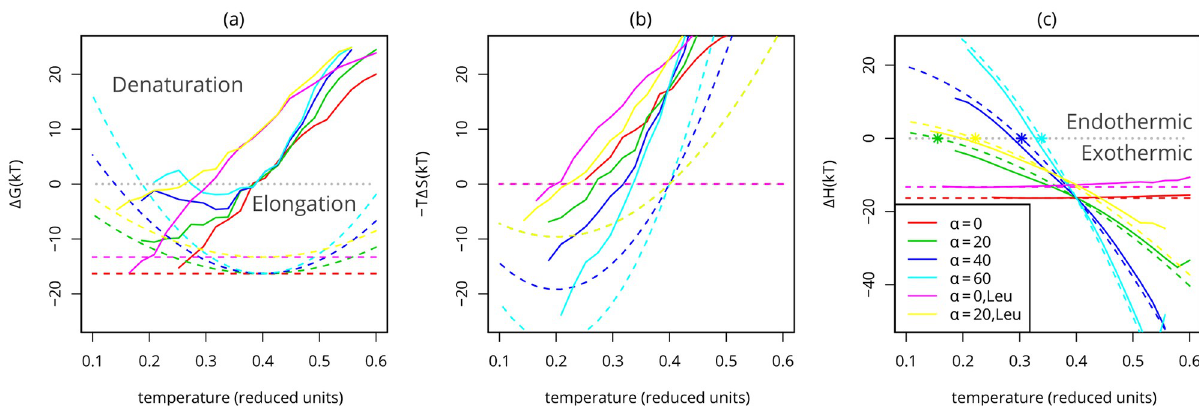
Fig 3. Temperature dependence of the free energy components. (A) Free energy, (B) Entropy and (C) Enthalpy of fibril elongation. The differences between the fully formed fibril ( C ext = 21) and the monomeric state ( C ext = 0) are calculated from the simulation of several different fibrils. The interaction strength of the Leucine-based fibrils is weaker, leading to a lower enthalpic contribution, effectively weakening the fibrils. Dotted lines and D ^ E ; these estimates are generated using Eqs 7 and 8 with indicate estimates for the hydrophobic contributions showing from left to right D ^ G hydr hydr corresponding α , Δ C h = − 6 and with an offset, E int = Δ H based on simulations with the equivalent peptide for α = 0; stars indicate the change of an exothermic to an endothermic process, based on the D ^ E estimate. It is clear that in our model the slope of the enthalpy of fibril elongation as a hydr function of temperature, is dominated by the temperature dependence of the hydrophobic